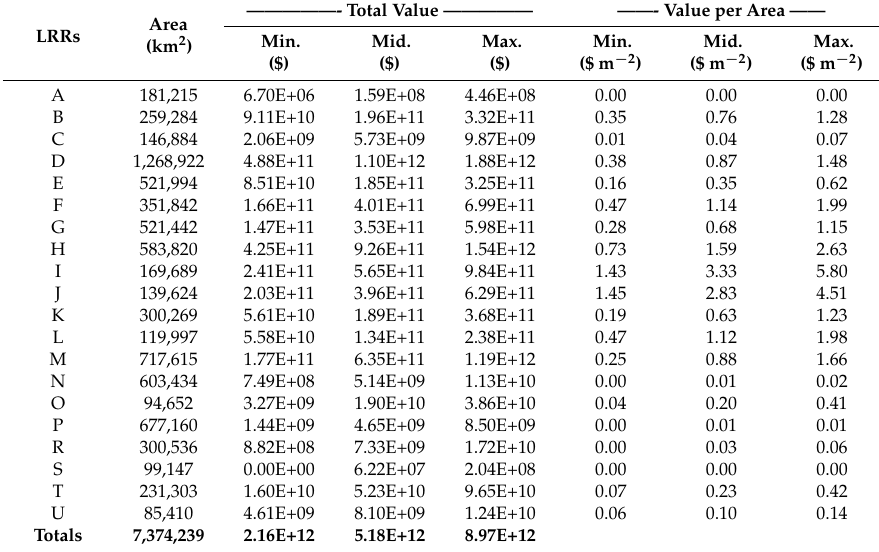
Table 3. Total SIC value and area-averaged value for Land Resources Regions (LRRs) based on [9] and